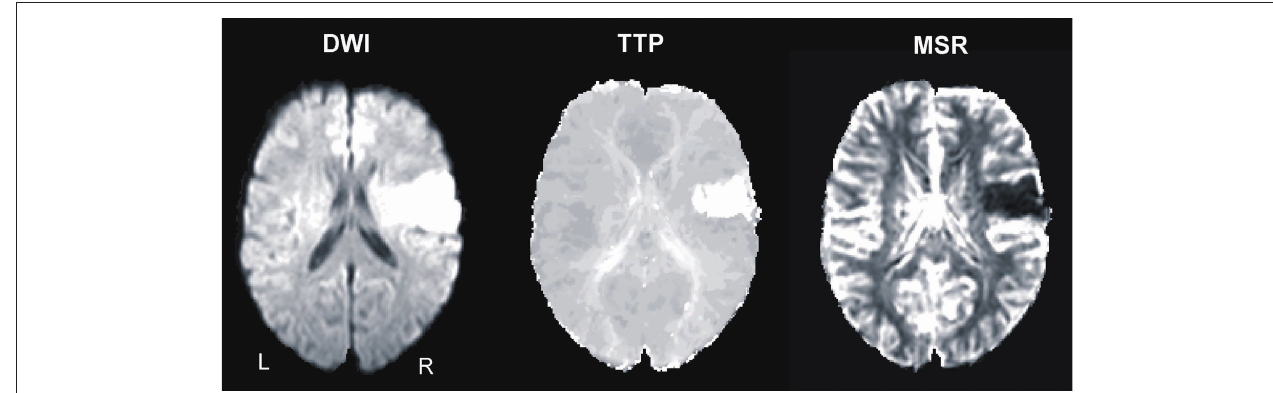
FIGURE 1 | Example from one patient’s normalized diffusion-weighted imaging (DWI) as well as time-to-peak (TTP) and maximal signal reduction (MSR) perfusion